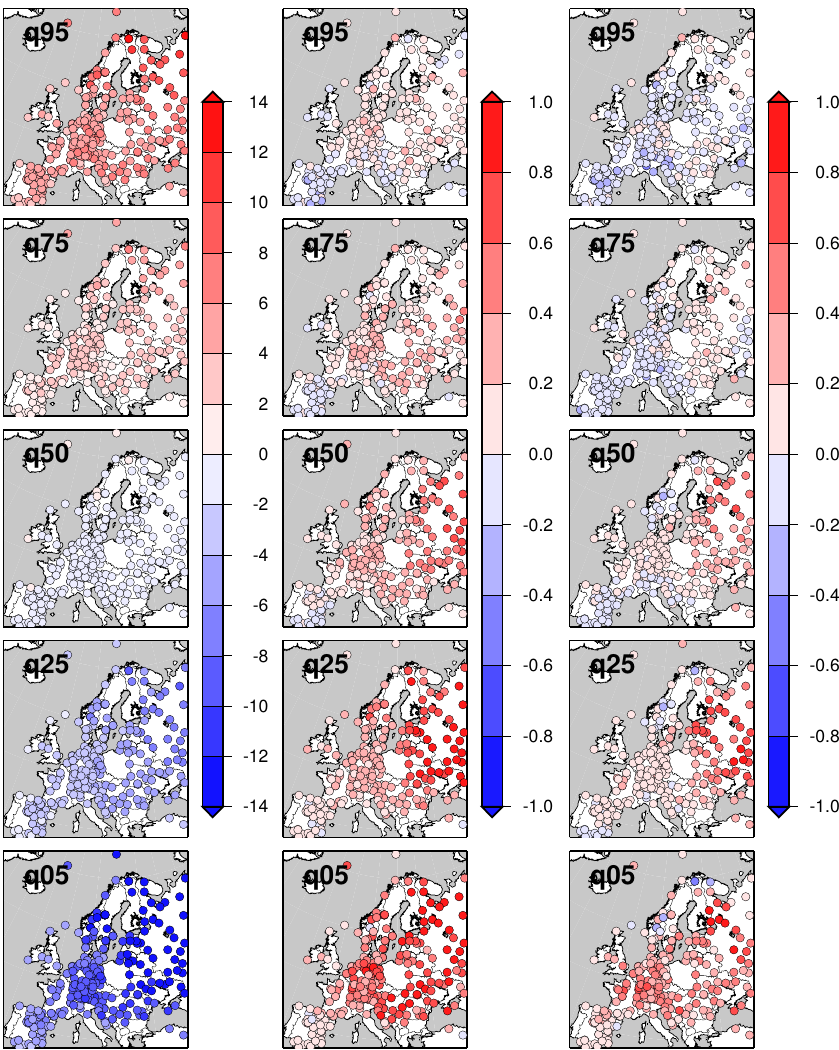
Fig. 7. Left column: 5th, 25th, 50th, 75th and 95th quantiles of winter temperature anomalies in Europe from the ECA&D set (in ◦ C). Central column: differences of quantiles between observed and simulated temperature anomalies with “static” weather generator. Right column: differences of quantiles between observed and simulated temperature anomalies with “dynamic” weather